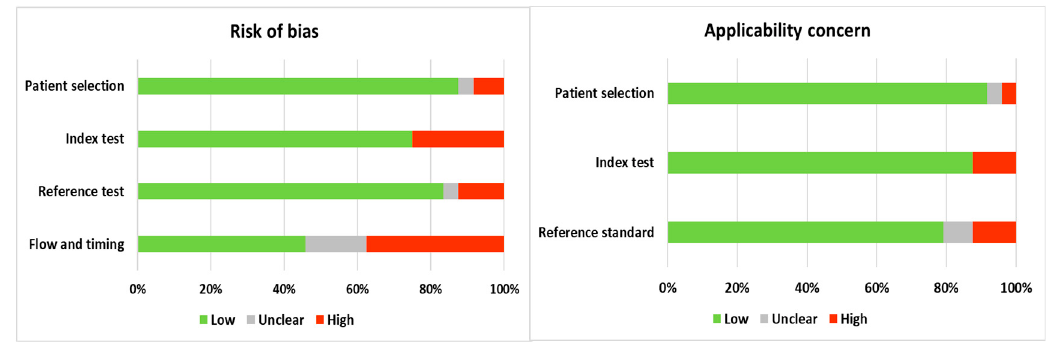
Figure 2. Quality assessment of Diagnostic Accuracy Studies 2 (QUADAS-2). Proportion of studies with low, high, or unclear risk of bias.